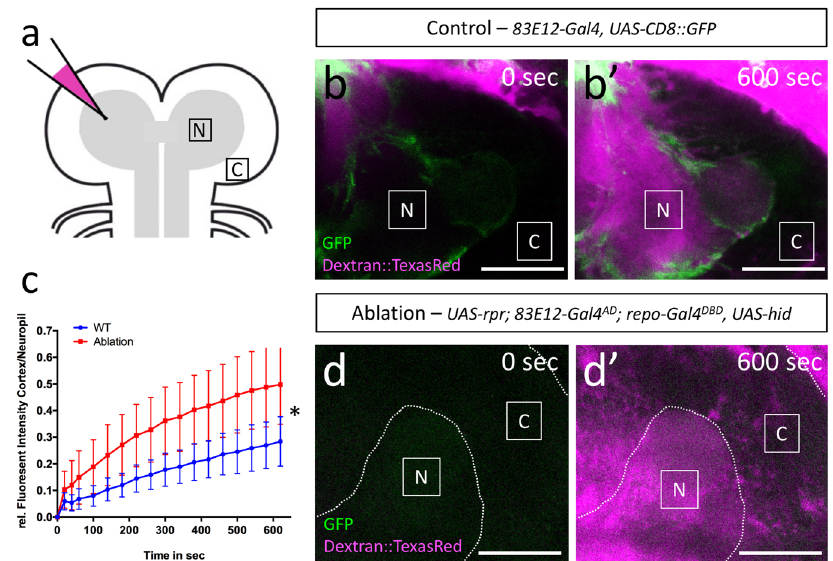
Fig. 5 Ensheathing glial cells form an internal barrier around the neuropil. a Schematic depiction of the dye injection experiments. Fluorescently labelled 10 kDa dextran was injected into the left hemisphere of a wandering third instar larva. Diffusion of the dye was monitored at two positions. In the neuropil (N) and in the cortex (C) harboring all neuronal cell bodies. b , b ’ Stills of a representative movie of a larval brain lobe with the genotype [ n = 5; 83E12-Gal4, UAS-CD8::GFP ] following dye injection, time is indicated. c Quanti fi cation of dye diffusion rate in larvae of the genotype [ 83E12-Gal4, UAS-CD8::GFP ] (blue line) and [ UAS-rpr; 83E12-Gal4 AD , repo-Gal4 DBD , UAS-hid ] (red line) ( n = 5, standard deviation is shown, * p = 0.0181; unpaired t -test, two-tailed). d , d ’ Stills of a representative movie of a larval brain lobe with the genotype [ n = 5, UAS-rpr; 83E12-Gal4 AD ; repo-Gal4 DBD , UAS-hid ] following dye injection. Scale bars are 50 µ m. Source data are provided as a Source Data fi